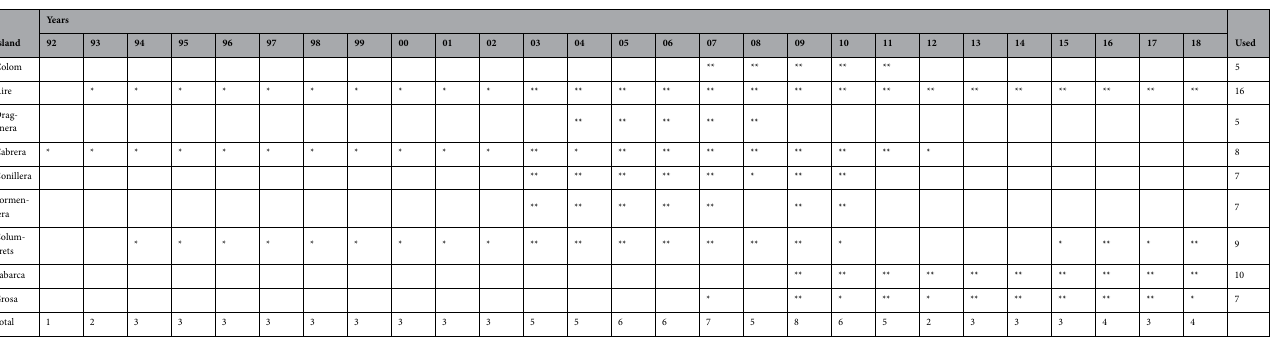
Table 1. Period of activity of the ringing stations located on each island between the years 1992 and 2018. * or ** identify years when the ringing station was operating on each island. **Identify years that fulfill the conditions described in the text to be used in analyses while *are years before 2003 or years that did not fulfill those conditions. The column Used shows the number of years whose data were used in analyses for each island.